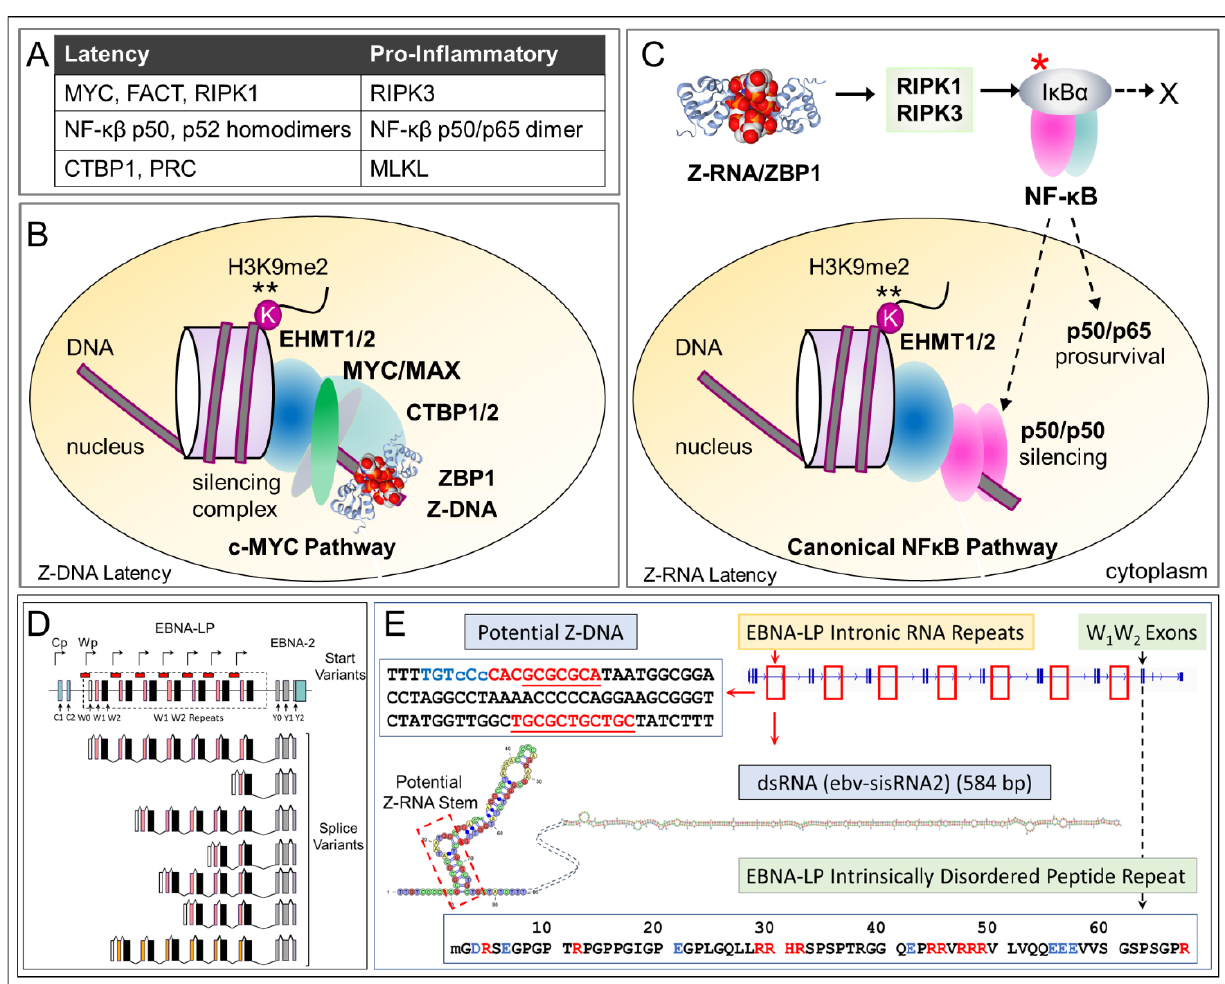
Figure 6. Different pathways for ZNA dependent EBV latency. ( A ). The factors and pathways associated with ZNA latency differ from those shown in Figure 1 that promote ZBP1 induced cell death. The MYC pathways depend on the interaction with the FACT complex as described in the text [72], while the NF- κB dependent transcriptional silencing likely rely on the p50 homodimer in acute infection and the p52 homodimer in chronic infection. Both dimers lack a transactivation domain and are known to induce histone H3K9 methylation [73]. ( B ). Z-DNA dependent latency. The MYC induced Z-DNA formation localizes ZBP1 and other members of the CTBP1 complex to that region [74]. MYC also binds EHTM1 to induce H3K9 methylation [75]. ( C ). Z-RNA induced latency . The outcome of NF- κB activation depends on context. In addition to well -known pro-inflammatory roles [76], the p50 homodimer (encoded by NFKB1) can induce H3K9 methylation to suppress interferon induced genes [73] . In this case, phosphorylation of the IκBα (indicated by a r ed asterisk) protein leads to its ubiquitination and removal by proteolysis (indicated by a cross). The p50 and p65 NF- κB subunits can then enter the nucleus. The non -canonical NF- κB pathway is based on p52 homodimers encoded by NFKB2. ( D ). The EBV early region contains the essential latency protein EBNA-LP gene (See Figure 5A for entire EBV genome) and repeats of the W1 and W2 exons, as indicated by differently colored vertical stripes. W0, C1, C2 and Wp represent EBV promoters. Alternative transcription start sites are indicated by the bent arrows. RNA splice forms are also presented (based on Figure 1 from [77]). The red boxes indicate the intron repeat sequences that overlap the BWRF1 open reading frame and encode 586 base pair RNA hairpins [64]. E ). The potential EBNA-LP scaffold for regulating EBV gene expression consists of an intronic long-noncoding RNA that forms Z-RNA and RNA hairpins, plus the intrinsically disordered peptide the gene encodes (basic amino acids are colored in red). The Z-DNA forming sequences in the 7 repeats are indicated in red letters with blue indicating an extended Z- forming region that lacks a perfectly alternating purine/pyrimidine repeat (indicated by dotted lines under residues and small letters for the bases out of alternation). The Z- RNA stem (shown within the dotted box) forms from the complementary bases that are underlined.